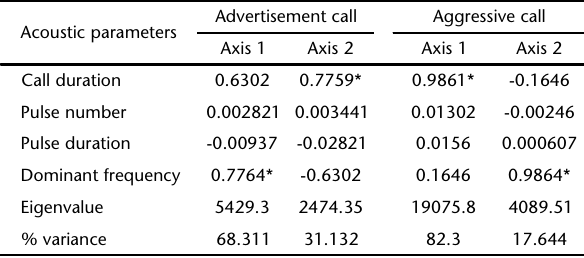
Table I. Factor loading of acoustic parameters of the advertisement and aggressive calls of Hypsiboas goianus included in the Principal Component Analysis.